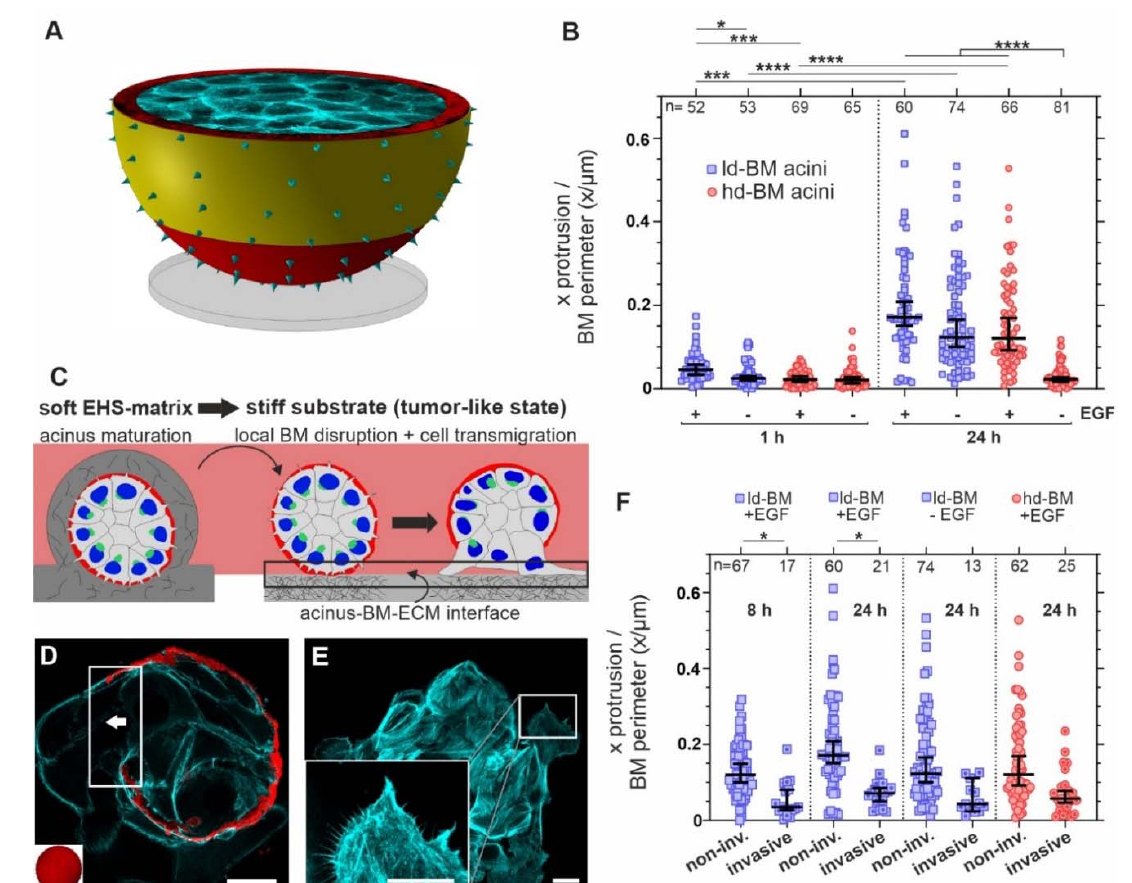
Figure 2. MS formation is fueled by tumor-like stiffness and oncogenic EGF. For analyses, MCF10A acini were fixed and IF-stained. ( A ) The schematic illustrates the acinar area analyzed for MS quantification (yellow area: start at 10 μ m above the glass up to the equatorial plane, defined as the cross-section with the largest diameter). MS were counted for several confocal image planes in this area (see material and methods for a detailed description). ( B ) Scatter plot summarizes MS numbers in non-invasive acini depending on the BM state and oncogenic EGF treatment over time. Counts of protrusions (x) were divided by individual BM perimeters (in μ m) of each analyzed confocal image. For a summary of observed acinar radii for BM perimeter calculation, see Supplementary Figure S1. ( C ) The experimental workflow of the designed invasion assay illustrates the invasive transition of benign acini transferred on a stiff substrate and conditional EGF stimulation (black box: area of invasion at the cell–BM–substrate interface) ( D ) A representative image shows local BM disruption (white box) and invasive cell transmigration (white arrow indicates the direction of cell migration) in an EGF-treated acinus. ( E ) Collectively outgrowing cell clusters showed frequent filopodial CP at the migration front. For additional images, see Supplementary Movie S4. ( F ) Scatter plot compares the lateral MS formation in invasive and non-invasive acini fractions depending on pro-invasive cues (24 h on glass). Sample size n : number of analyzed images of at least three independent experiments. Scatter plots: bars: median with 95% confidence interval. For statistical tests mean values per acinus were used: Mann–Whitney U-test with: **** = p < 0.0001, *** = p < 0.001, * = p < 0.05. Scale bars: ( D , E ) = 20 μ m.